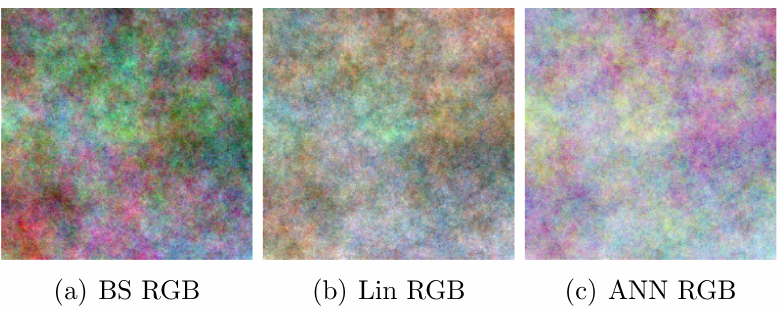
Figure 7. The RGB color composite images of the MSFI in Figure